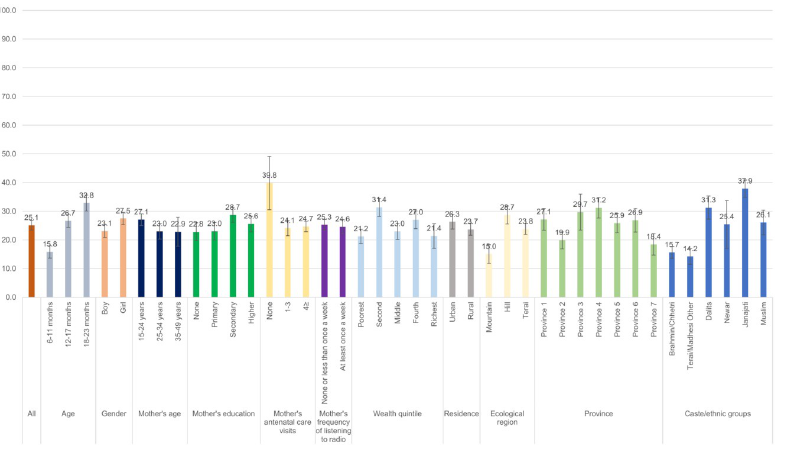
Fig 4. Percentage of Nepalese children aged 6 to 23 months consuming flesh foods by sociodemographic factors.